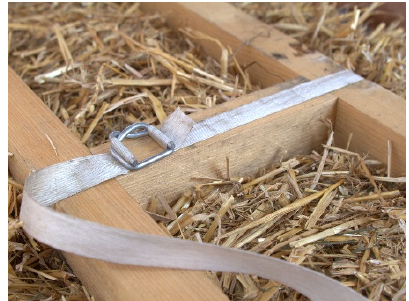
Figure 7. Fixing the bales with a composite polyester textile strap in the center.